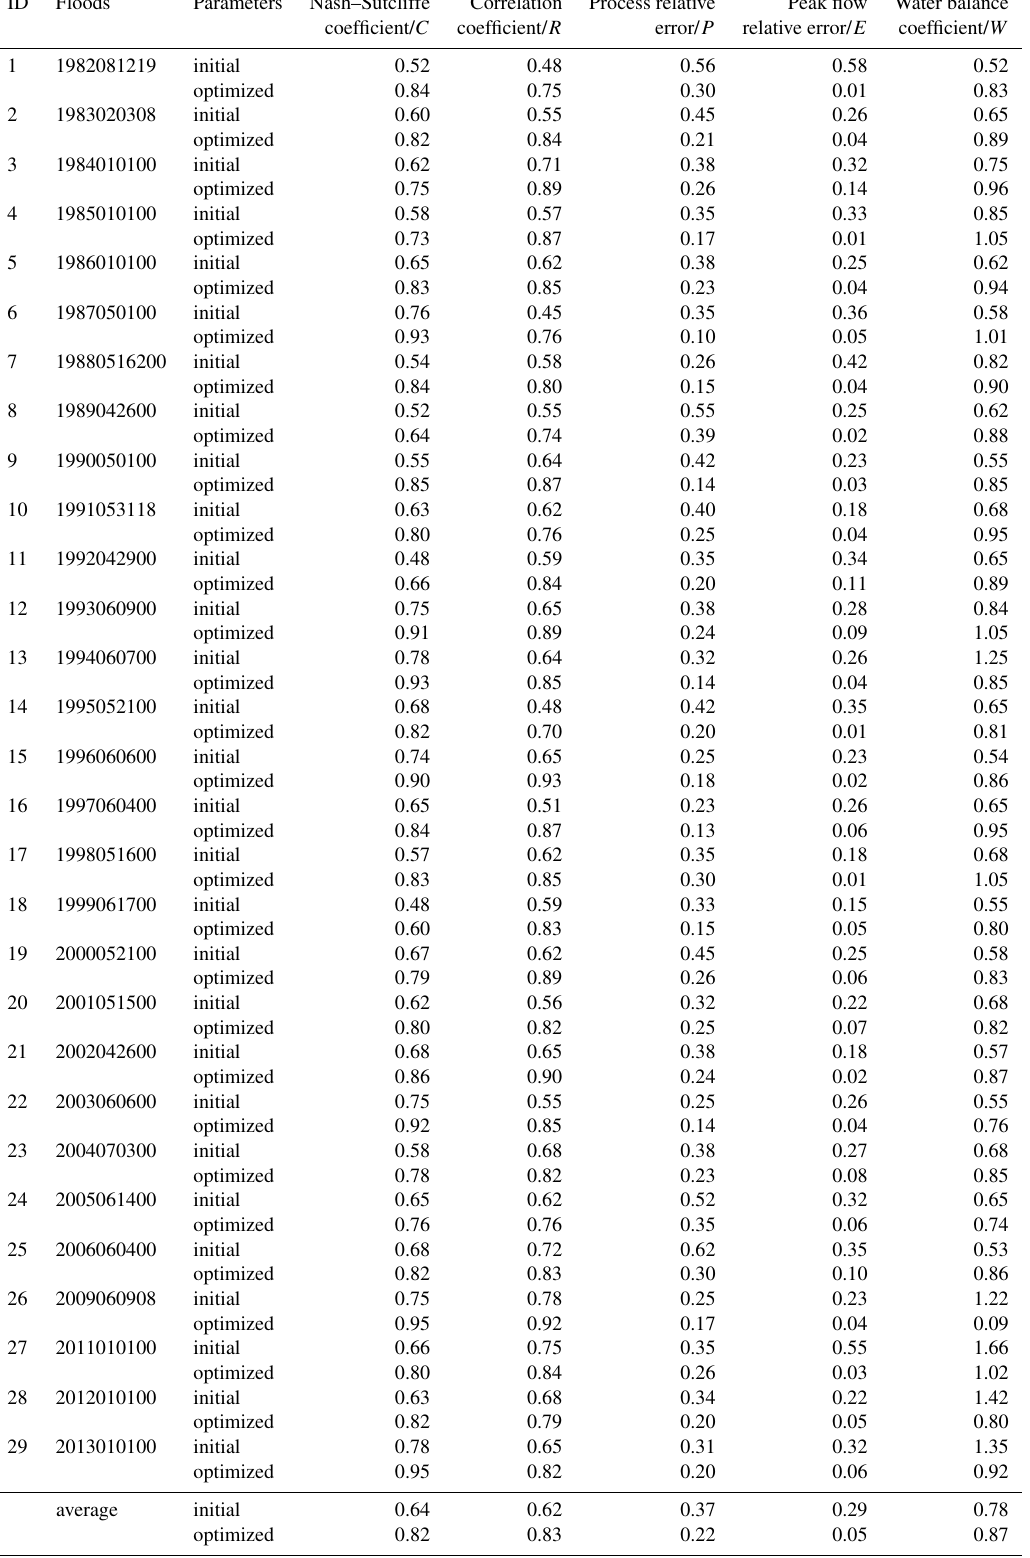
Table 4. Evaluation indices of the simulated flood